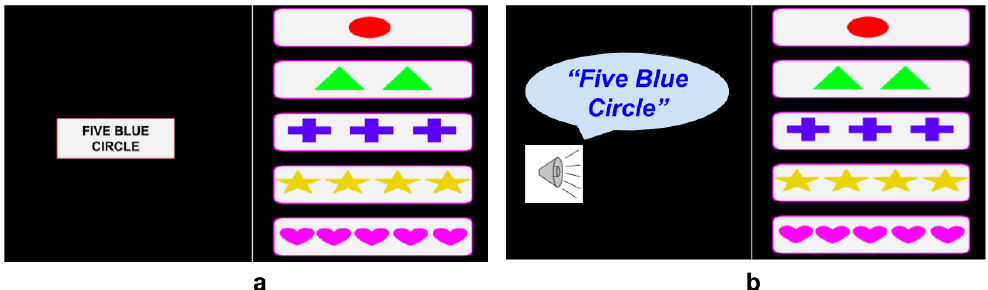
Figure 5. Textual Stimuli Version shown in ( a ) and Auditory Stimuli in ( b ).